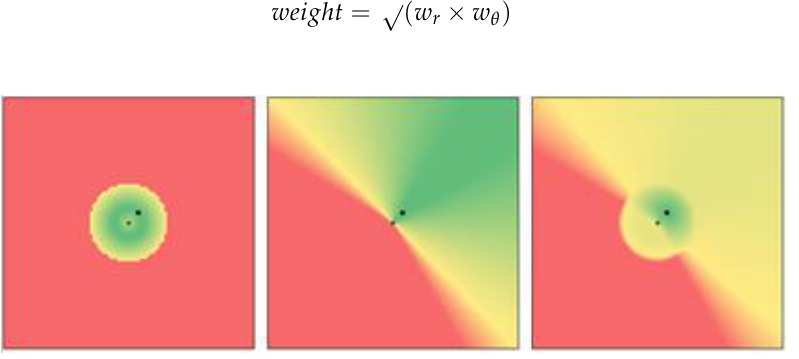
Figure 7. Visualisation of the particle weight functions for a ground truth location of (4, 4), meaning a displacement of 4 m in the x and y directions from the receiver, indicated by the dark square. The receiver is in the centre of each image at (0, 0). The weight function based only on distance is shown in the left image, and the weight function based only on the angle (direction) is shown in the middle image. The final combined weight function is shown in the right image. Red indicates a low likelihood, and green indicates a high likelihood of the emitter position matching the particle location.